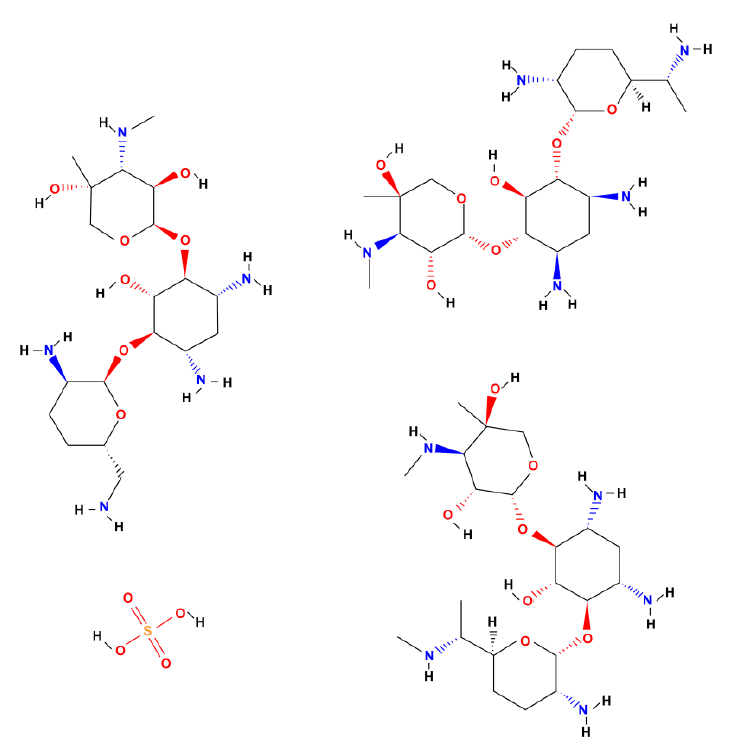
Figure 9. Chemical structure of gentamicin sulfate (GE).